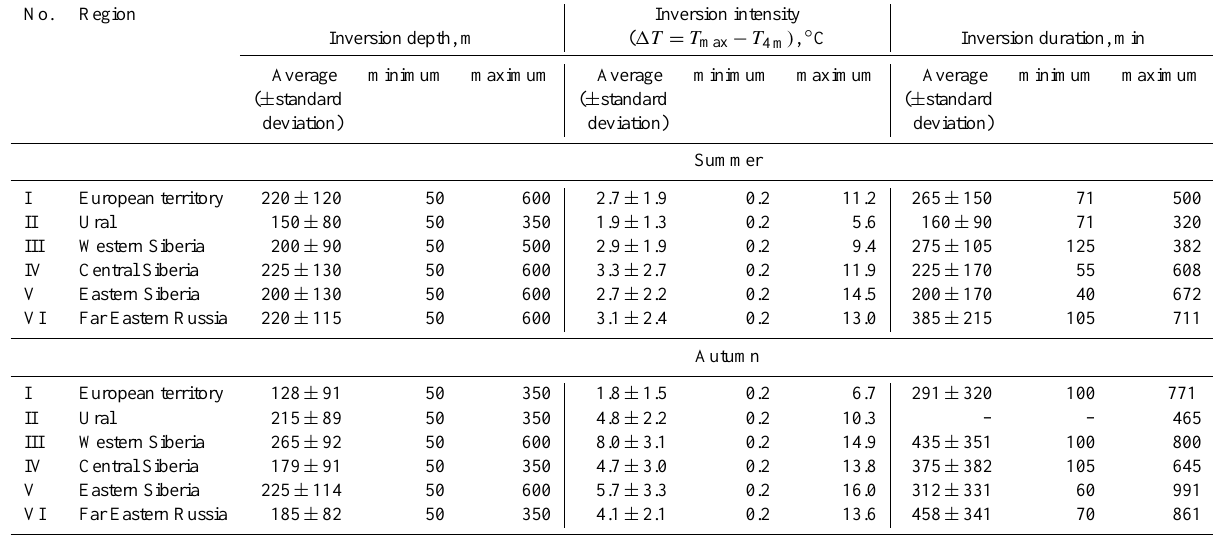
Table 4. Surface temperature inversion characteristics averaged for the studied Russian regions from the summer and autumn expeditions. The numbers of the regions: I – Moscow-Perm (0–1380km from Moscow); II – Perm-Ekaterinburg (1380–1904km from Moscow); III – Ekaterinburg-Novosibirsk (1904–3283km from Moscow); IV – Novosibirsk-Irkutsk (3283–5136km from Moscow); V –